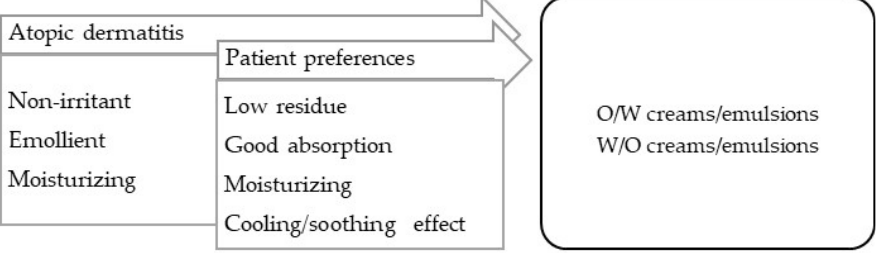
5. Pigmentation 5. Pigmentation disorders.